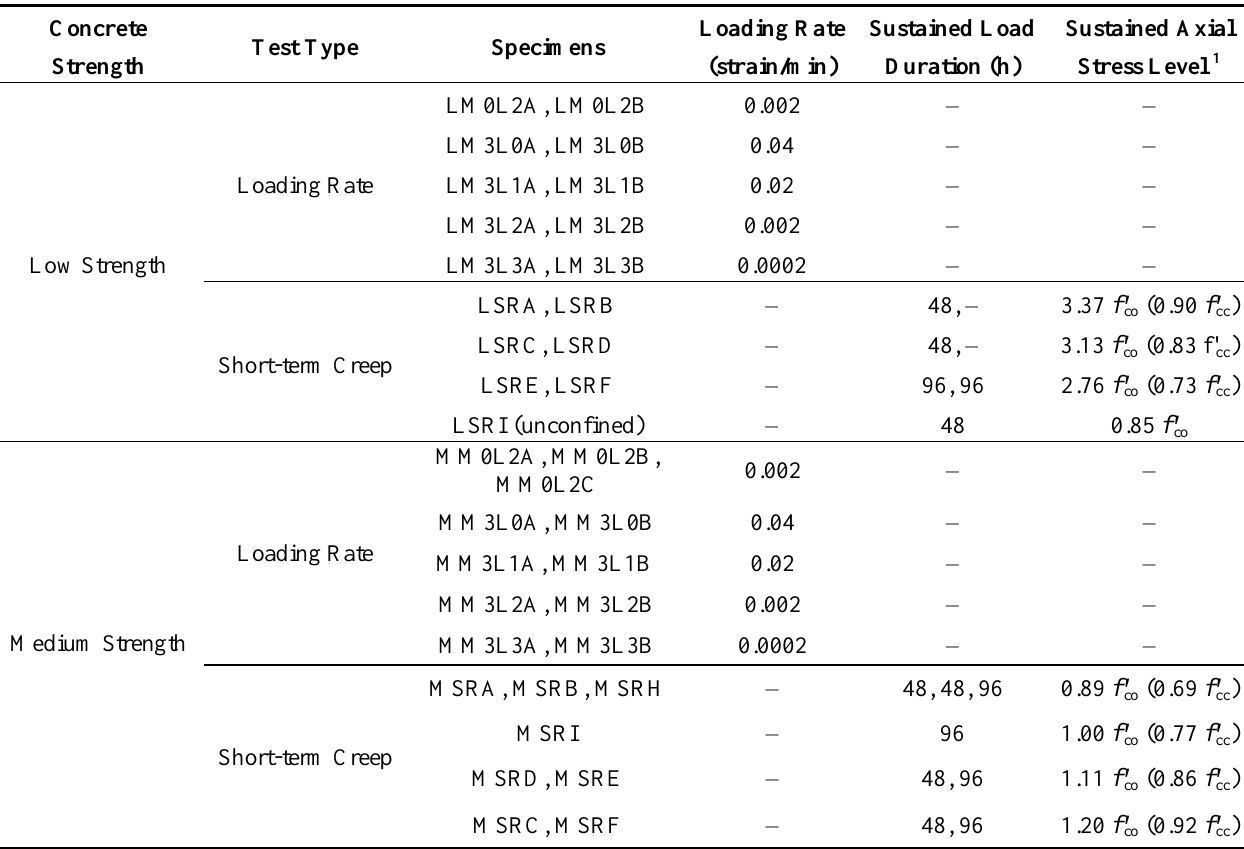
Table 1. Tested specimens and investigated parameters.